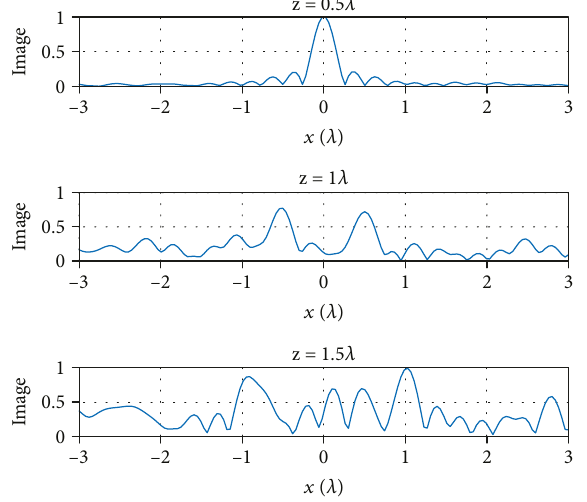
Figure 5: Reconstructed images when using 9 resonant dipole antennas. For this example, the parameters are z =1.5 λ , d = λ , d =2 λ , s = λ /8, and D =0.25 λ . These results are z 3 2 3 with SNR=20